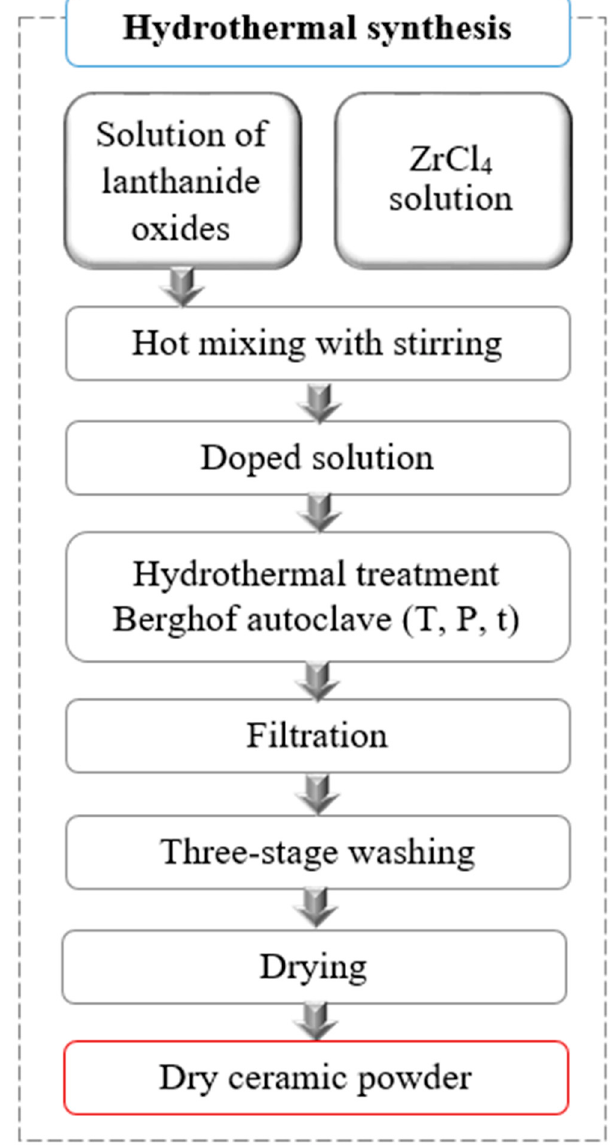
Figure 1. Schematic flowsheet of the hydrothermal process used for obtaining ZrO 2 powders doped with mixed rare earth oxides (REOs). Revised